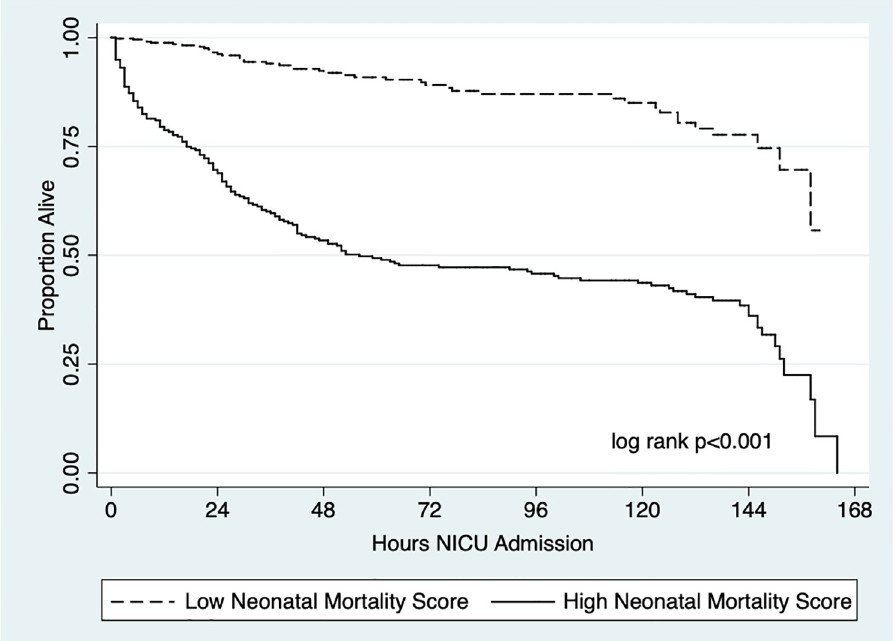
Fig 3. Kaplan-Meier survival curve comparing low and high neonatal mortality